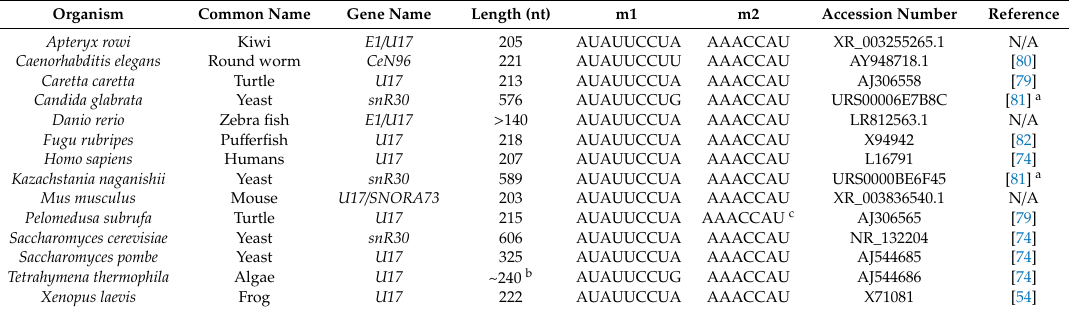
Table 1. Comparison of snR30 / U17 RNA across